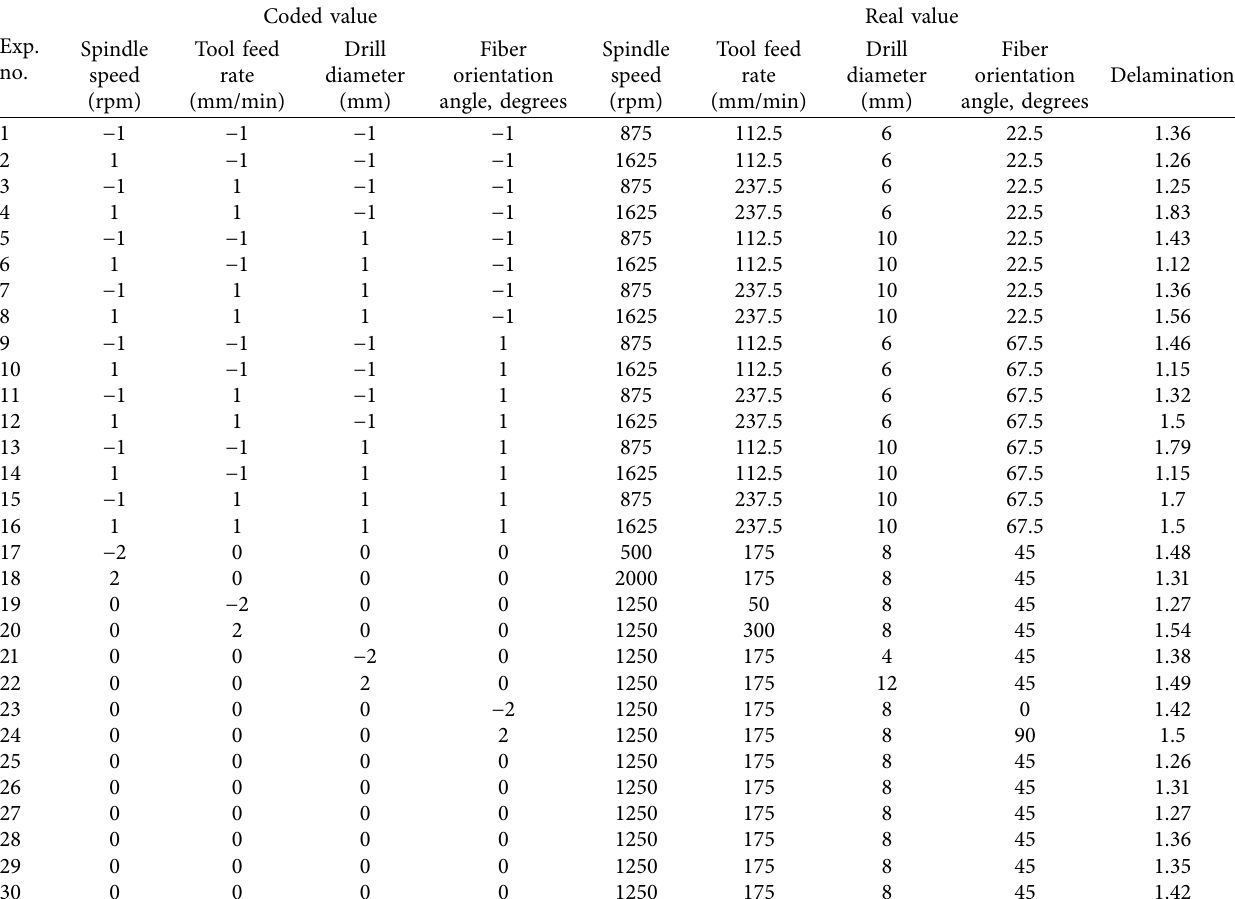
Table 4: Coded values, real values, and delamination.